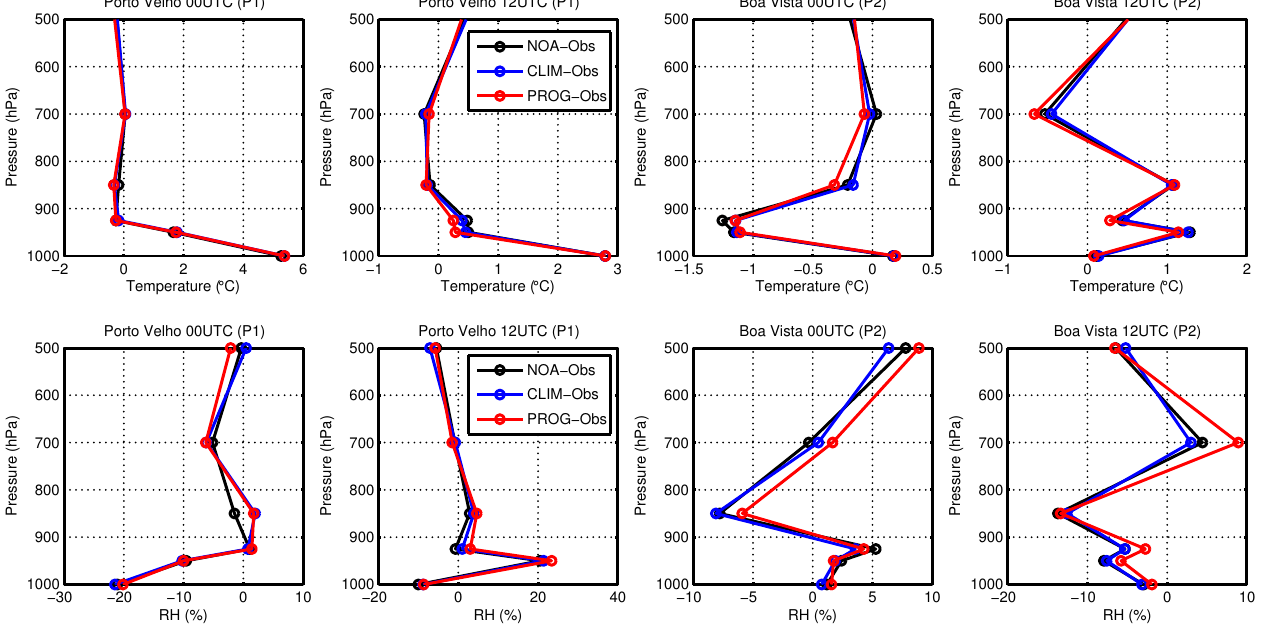
Figure 10. Profiles of modelled minus observed temperature and relative humidities from radiosondes at P1 and P2 (locations shown in Fig.